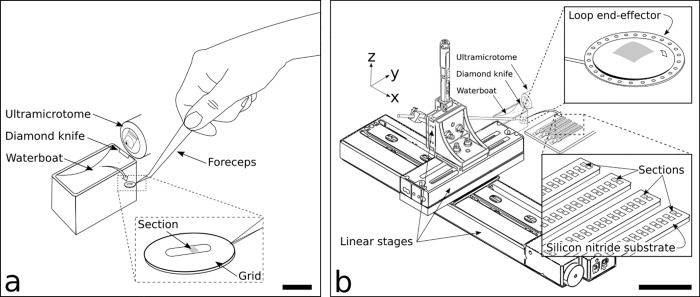
Traditional serial sectioning (left) as compared to LASSO (right). (a). Sections are cut on an ultramicrotome using a diamond knife and slide into an adjoining water-filled waterboat, where they float on the water surface. Using a TEM grid held by forceps, a skilled user picks up section(s) from the waterboat onto a TEM substrate, e.g., grid (Fig 2A, inset). Scale bar: 10 mm. (b) For LASSO, sections are fabricated in an identical manner as in Fig 2A, using the same ultramicrotome, diamond knife, and waterboat. From the waterboat, sections are picked up using a loop end-effector, actuated via a robotic system composed of three orthogonal linear axes. Held in the loop end-effector by surface tensions forces (Fig 2B, inset, top right), the section is placed onto microfabricated silicon nitride substrates (Fig 2B, inset, bottom right). Multiple sections are placed onto the same substrate, with each section having its own imaging aperture; a set of substrates compose a “batch,” (e.g., 4 substrates = 1 batch, as shown in Fig 2B, inset, bottom right). Scale bar: 100 mm.